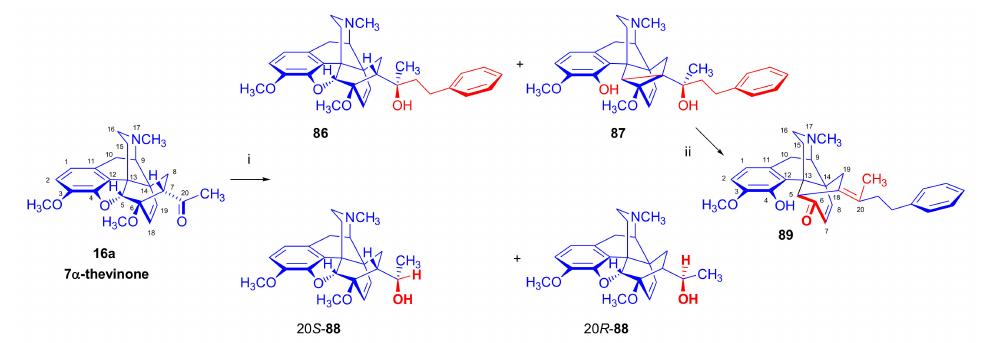
Figure 30. Reaction of thevinone ( 16a ) with 2-phenylethylmagnesium bromide. Reagents and condi- tions : (i): six equiv. PhCH 2 CH 2 MgBr, toluene-THF, 2 h; (ii): 1M HCl, reflux, 4